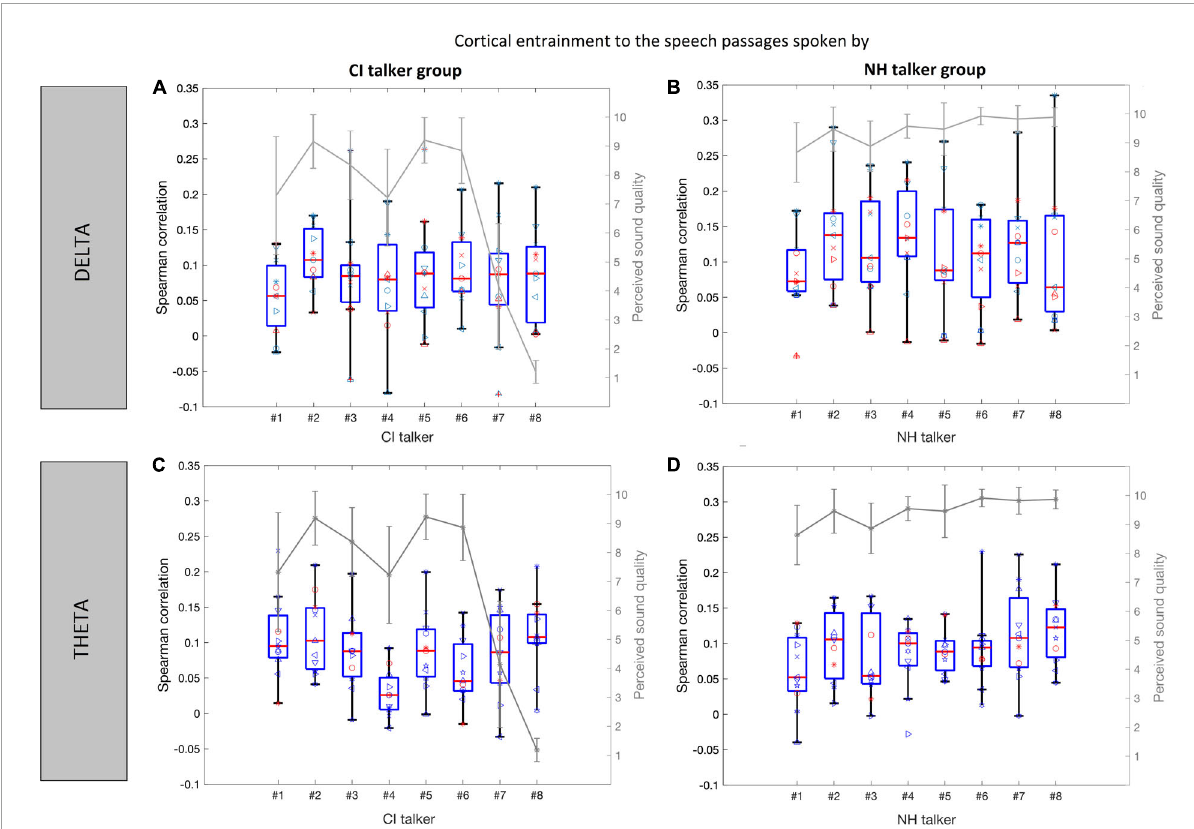
FIGURE10 Cortical entrainment to speech envelope (filtered to match delta and theta bandwidth) in the normal-hearing listeners is shown for each of the speech passages from the CI talker group (A,C) and NH talker group (B,D) in delta and theta band, respectively. The data are represented in the form of the boxplots depicting medians (center mark) and interquartile ranges (the bottom and top edges of the box indicate the 25th and 75th percentiles). The boxplot shows the entrainment data variance across listeners, and the individual listenerŠs data points are plotted over it. Each listener is shown with a different symbol. The perceived sound quality curve (gray) is also shown for